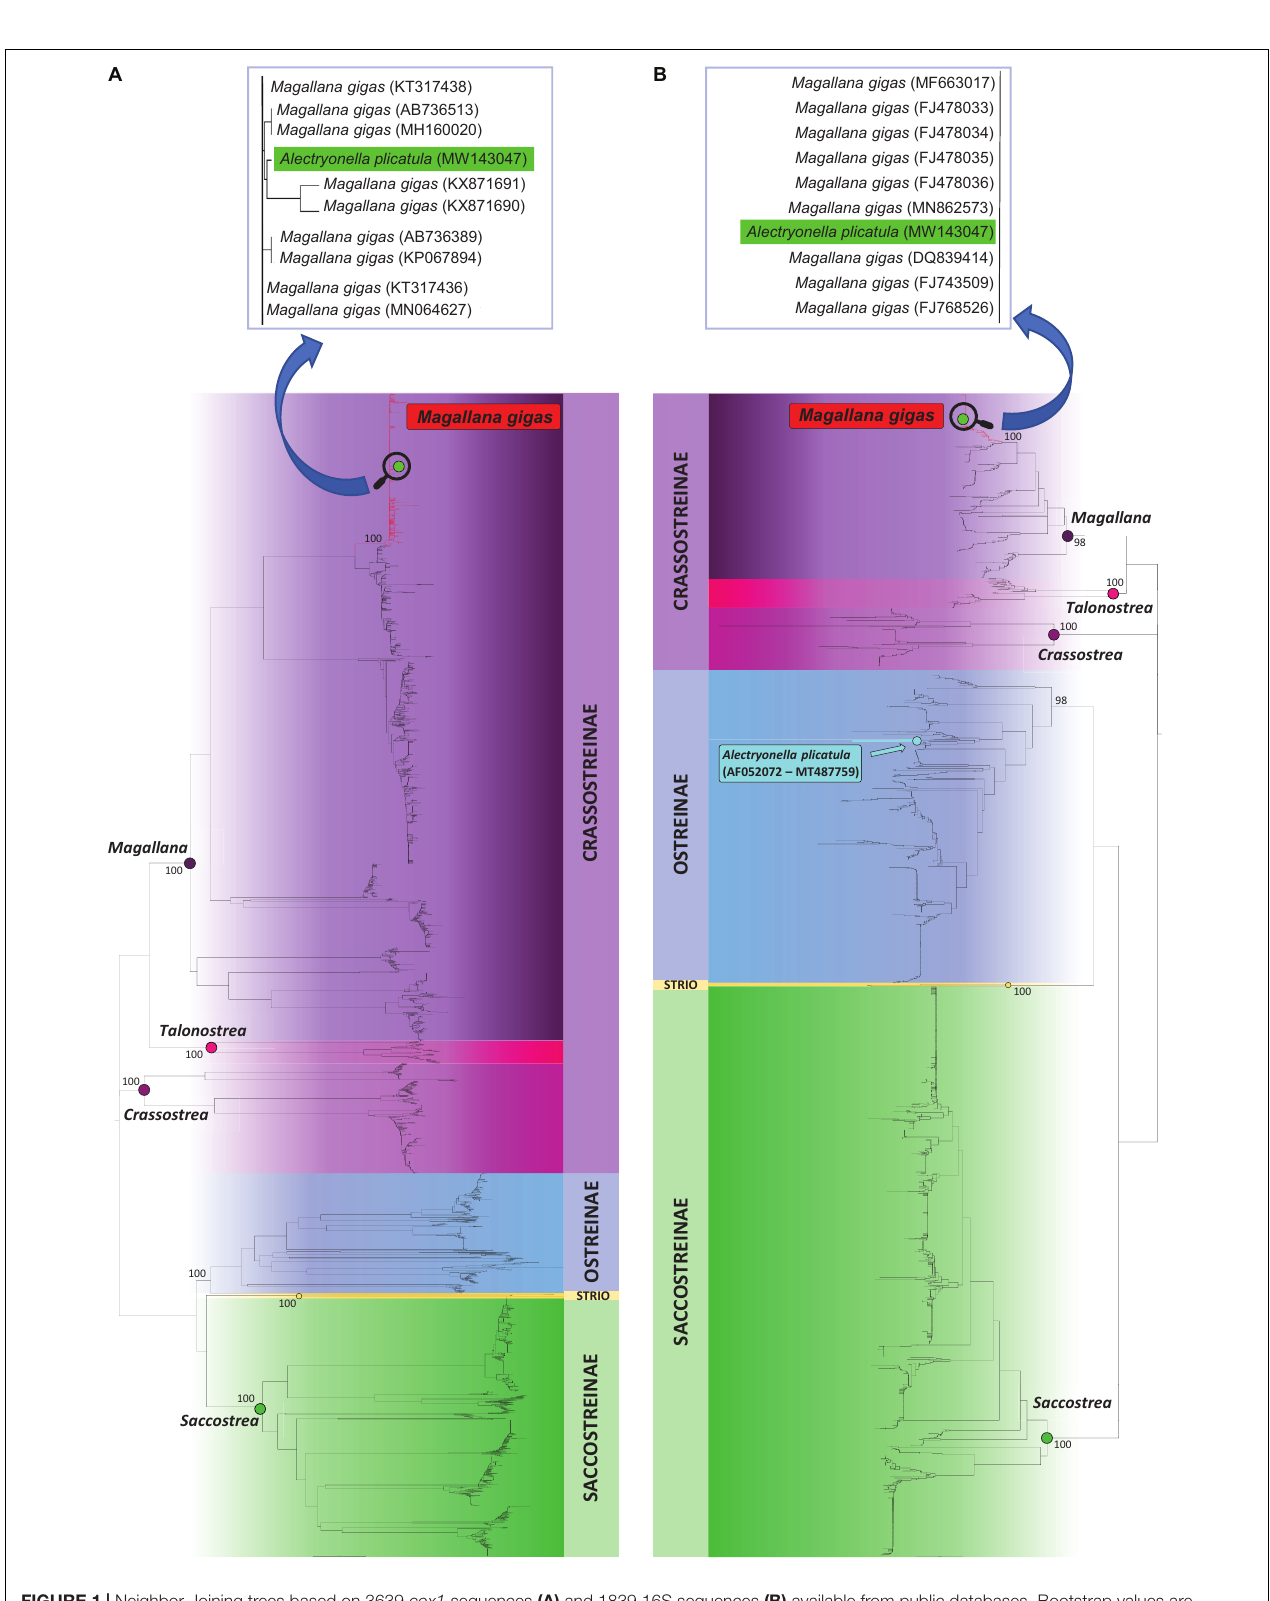
FIGURE 1 | Neighbor-Joining trees based on 3639 cox1 sequences (A) and 1839 16S sequences (B) available from public databases. Bootstrap values are reported in correspondence of main nodes. In both trees MW143047 is nested within the clade formed by sequences of Magallana gigas within the Crassostreinae lineage. Instead, available 16S rRNA sequences of Alectryonella plicatula generated in previous studies cluster within the Ostreinae lineage.